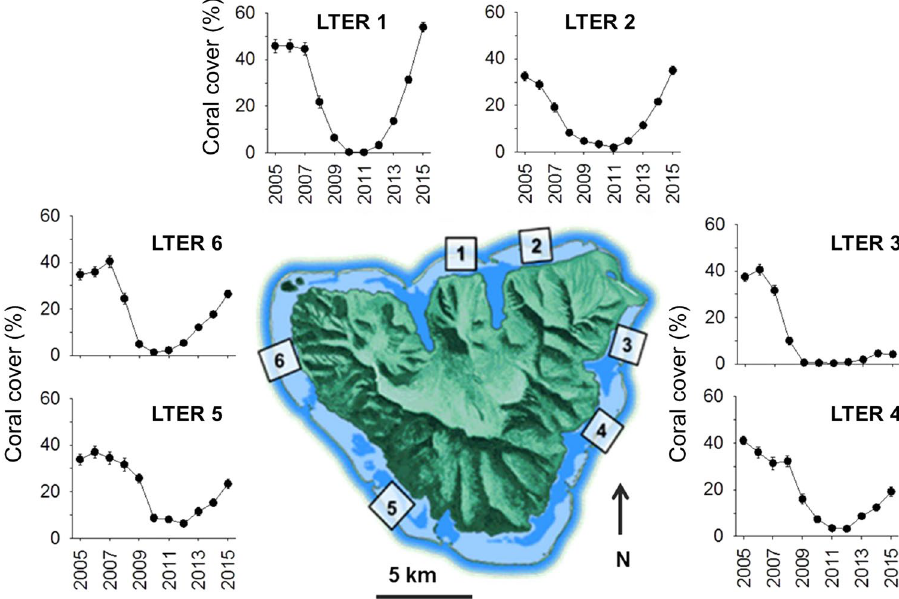
Figure 1. Spatial variation in mean ( ± SE) percent cover of live coral at 10 m depth at 6 fore reef sites around Moorea (n ~ 40 quadrats year − 1 site − 1 ), showing: (1) almost complete loss of coral cover at all 6 sites, and (2) strong spatial variation in rate of return of coral cover. Map of Moorea was based on an original image (ISS006-E-39837) provided courtesy of the Earth Science and Remote Sensing Unit, NASA Johnson Space Center (https://eol.jsc.nasa.gov) and was modified using Adobe Photoshop Elements v14.1 and Microsoft PowerPoint 2016.